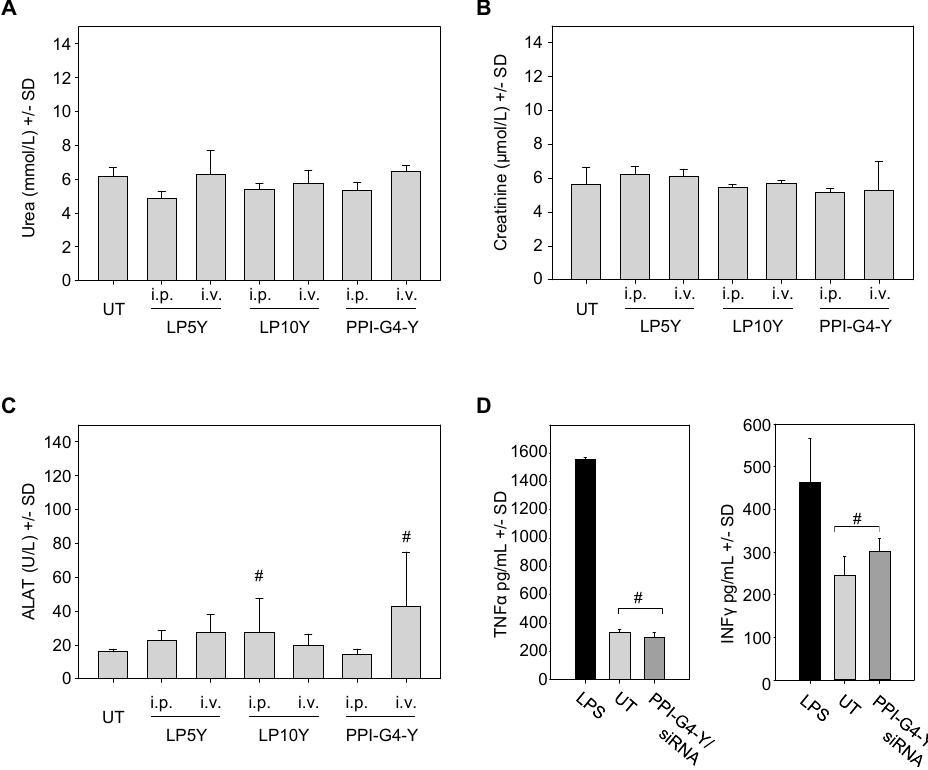
Figure 5. Determination of serum levels of ( A ) urea, ( B ) creatinine and ( C ) alanine-aminotransferase (ALAT) levels upon intraperitoneal (i.p.) or intravenous (i.v.) injection of mice with the tyrosine-modified PPI- or PEI-based siRNA complexes indicated on the x-axis. ( D ) Measurement of TNF α (left) and INF γ serum levels (right) upon i.v. injection of PPI-G4-Y/siRNA complexes.